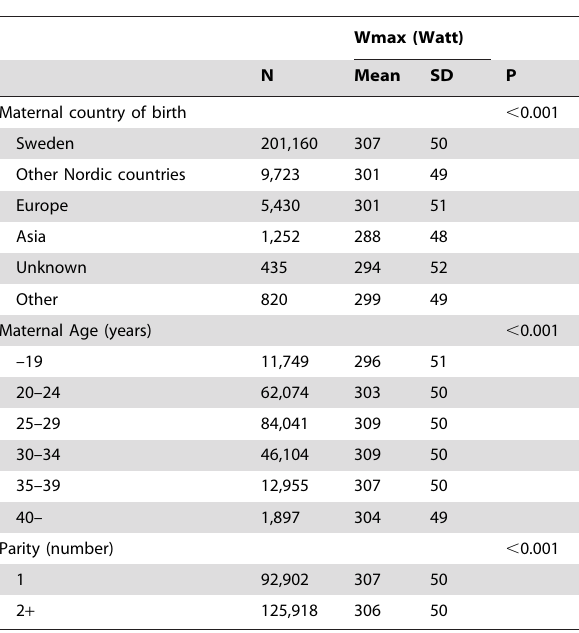
Table 5. Maximal exercise capacity by maternal characteristics (univariate